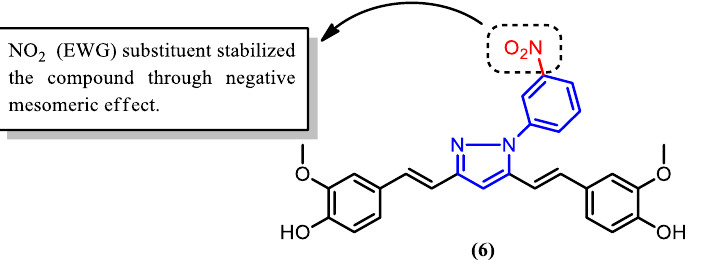
Figure 13. Pyrazole derivative ( 6 ) with a nitro substituent at the phenyl ring, which contributes to its enhanced bioactivity.